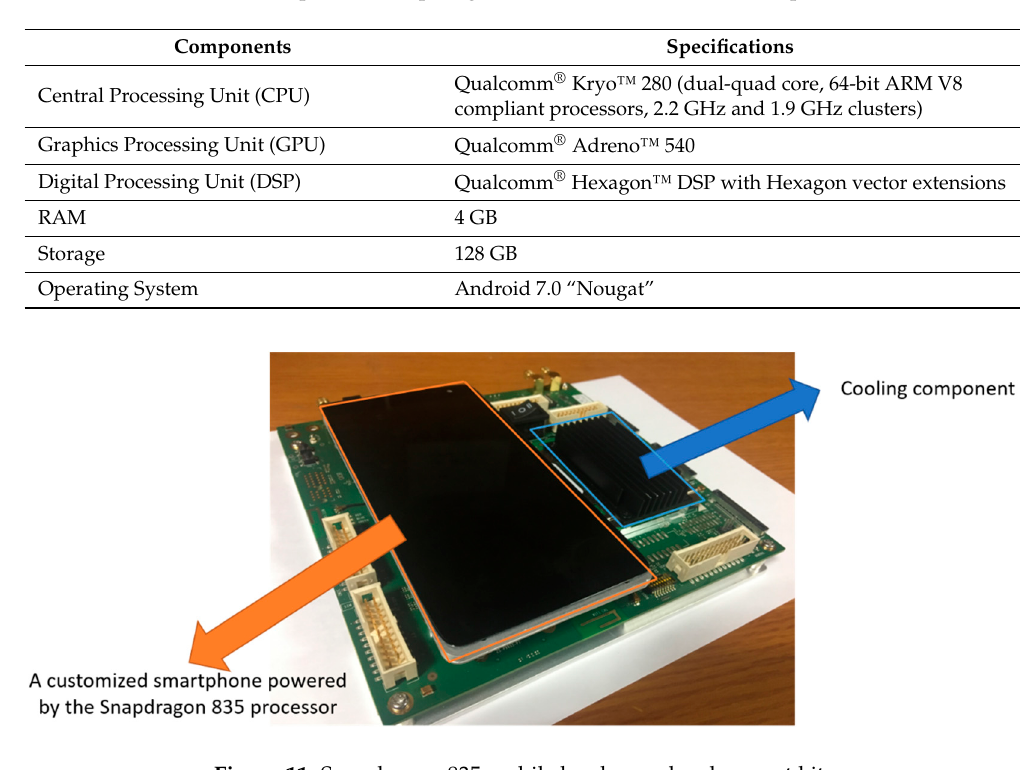
Figure 11. Snapdragon 835 mobile hardware development kit.